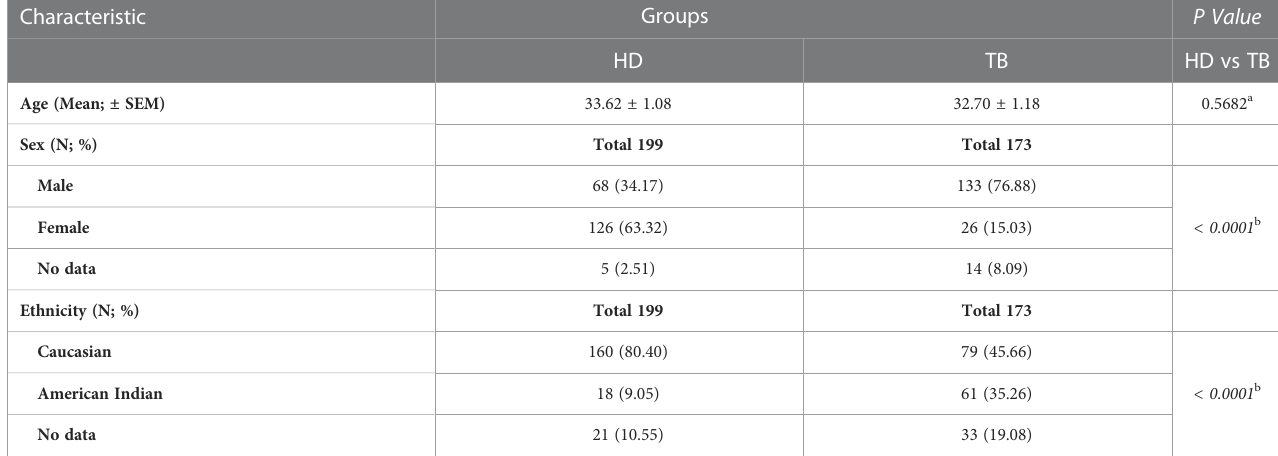
TABLE 1 Demographic Characteristics of patients with Tuberculosis (TB) and Healthy Donors (HD).